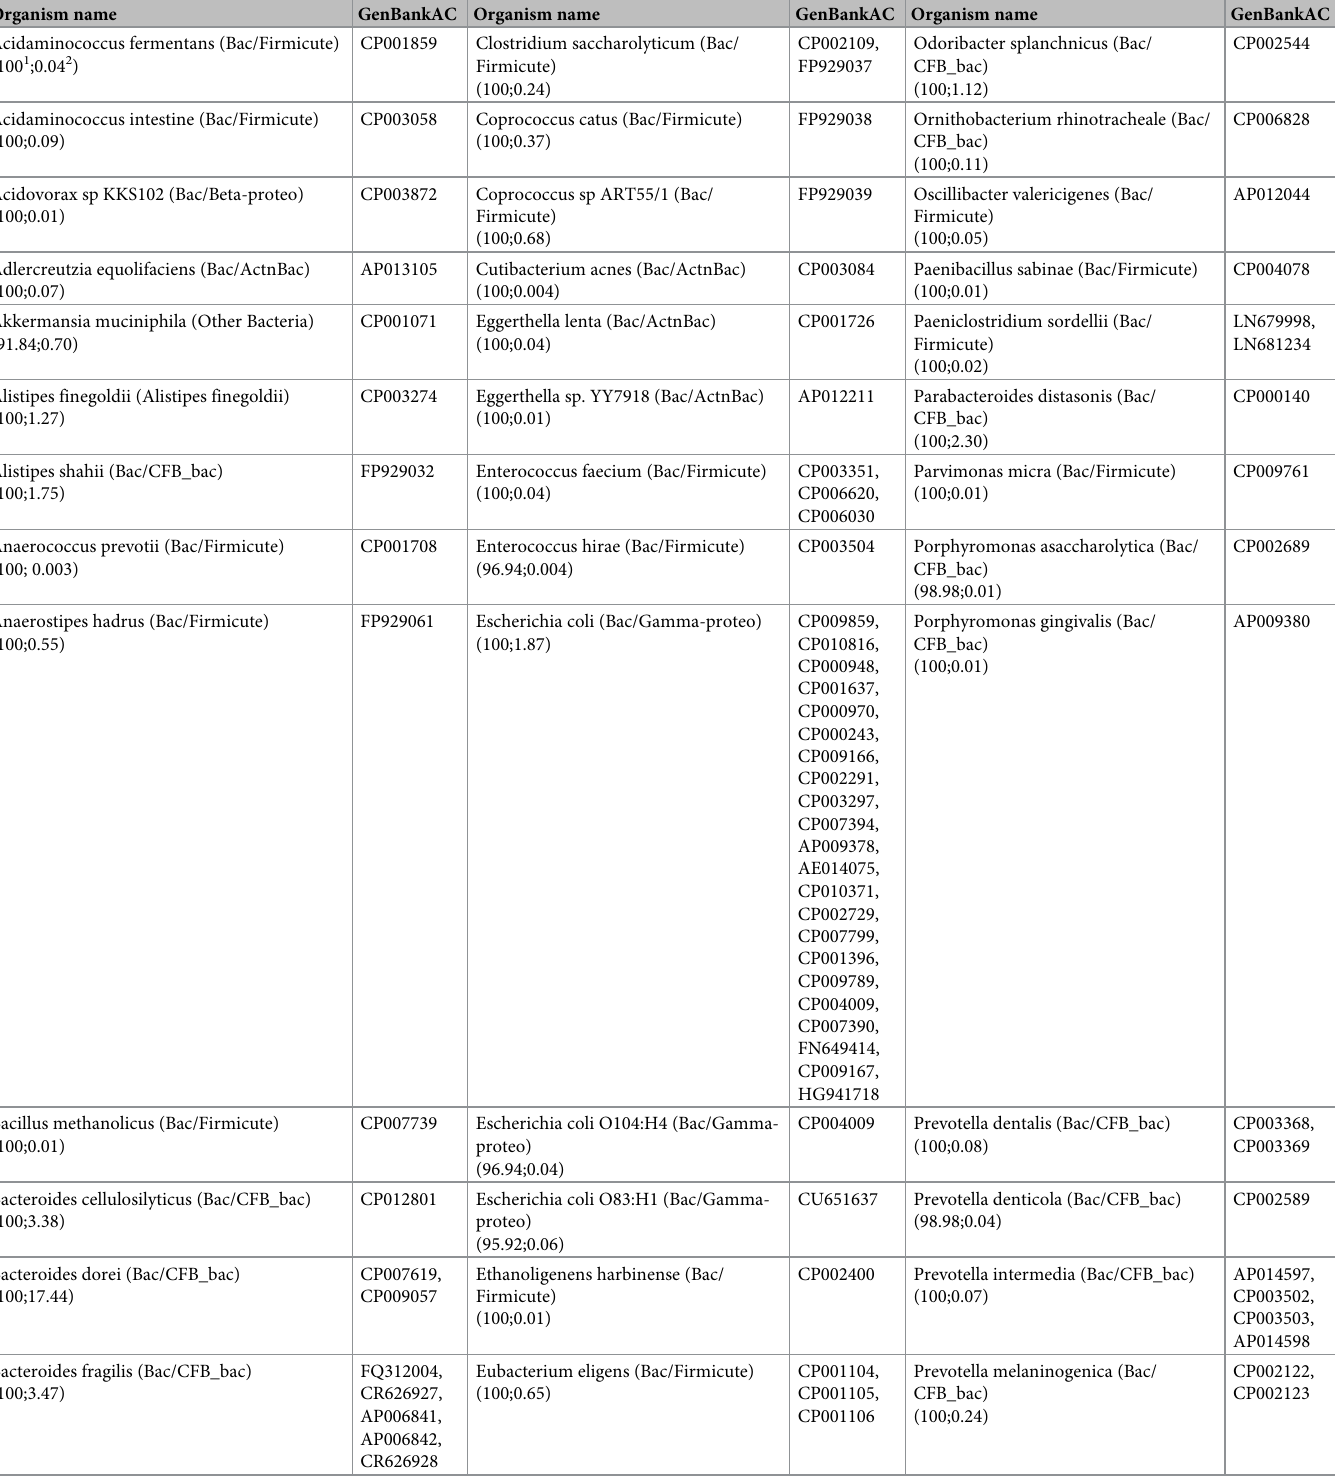
Table 2. List of 109 baseline species and their GenBank accessions found in healthy human